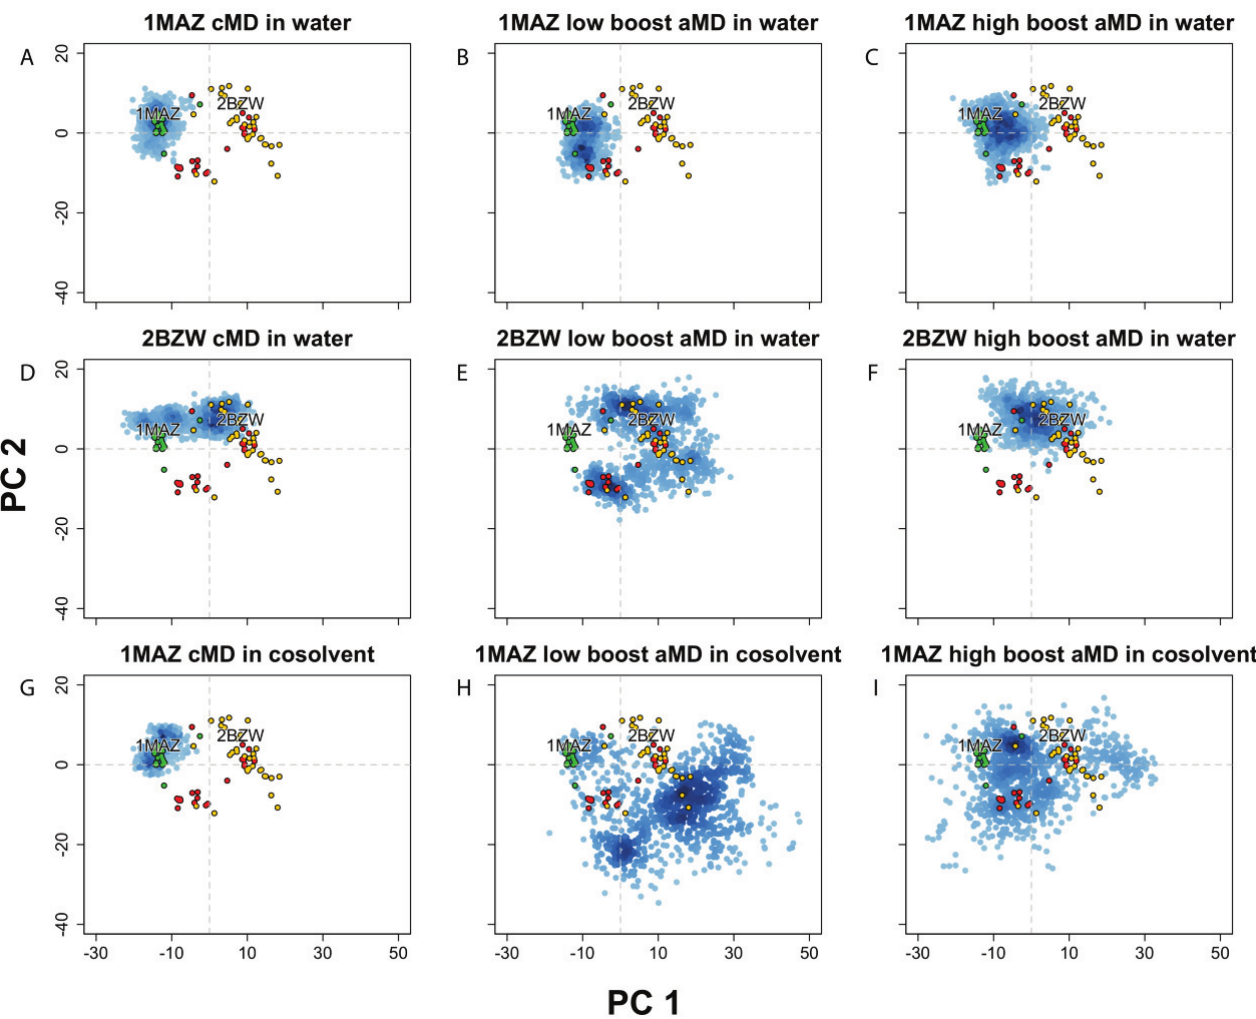
Figure 3. Projection of Bcl-xL conformations into the experimental structure PC1-PC2 subspace, from MD simulations using conventional MD (cMD) in water or a 20% v/v isopropanol/water cosolvent environment, along with accelerated MD (aMD) using low or high acceleration parameters. Simulations started with ( A – C ) apo-Bcl-xl (PDB code: 1MAZ) in water, with ( D – F ) Bad-bound Bcl-xL (PDB code: 2BZW) in water, and with ( G – I ) apo-Bcl-xl (PDB code: 1MAZ) in cosolvent environment. All simulations were run for 100 ns except for the 1MAZ cMD in cosolvent, which was run for 33